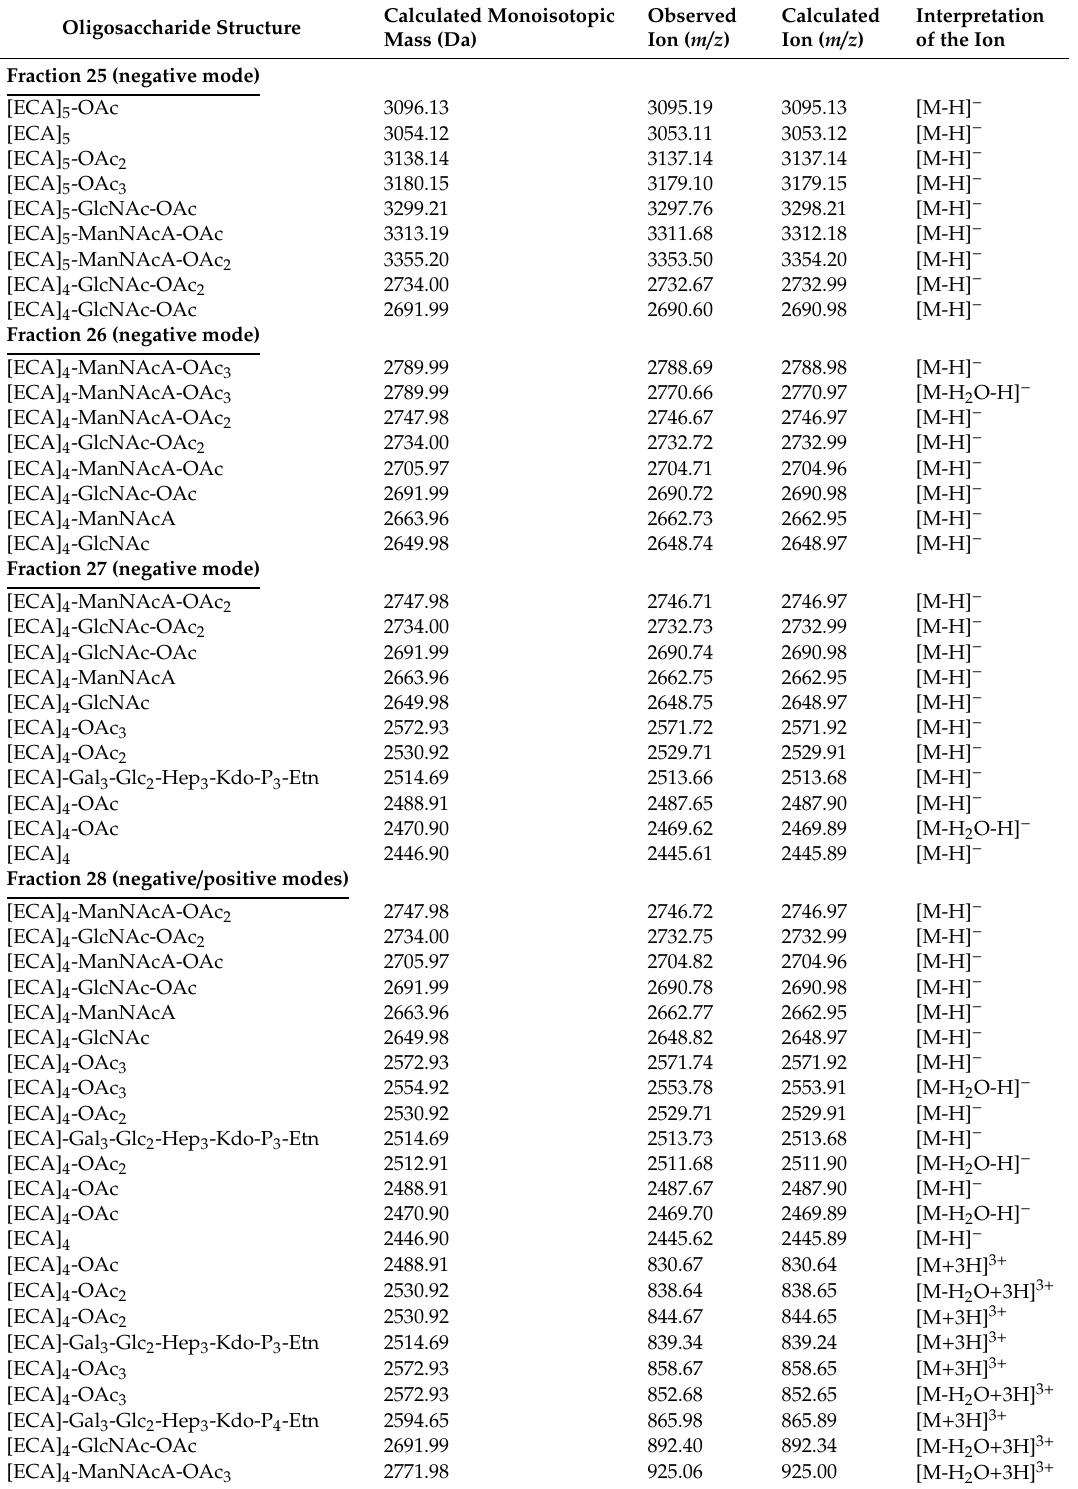
Table 4. Interpretation of matrix-assisted laser desorption / ionization-time of flight (MALDI-TOF) mass spectra of ECA-containing fractions 25, 26, 27, and 28 isolated from E. coli R4 LOS preparation. Oligosaccharide